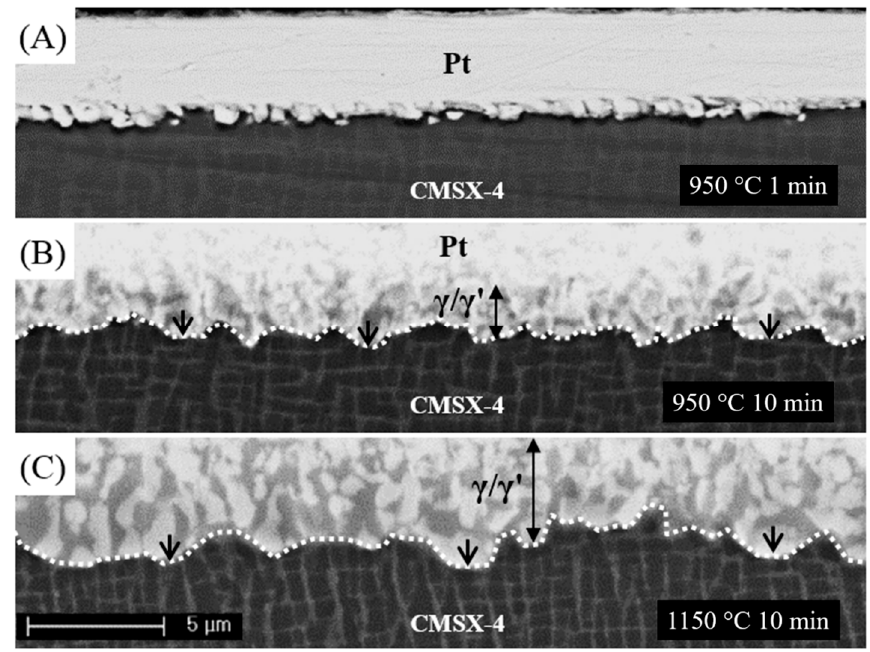
Figure 1. BSE imaging of the cross-sections of an as-electroplated Pt layer on a CMSX-4 after heat treatment in a vacuum: ( A ) 950 °C + 1 min; ( B ) 950 °C + 10 min; and ( C ) 1150 °C + 10 min.